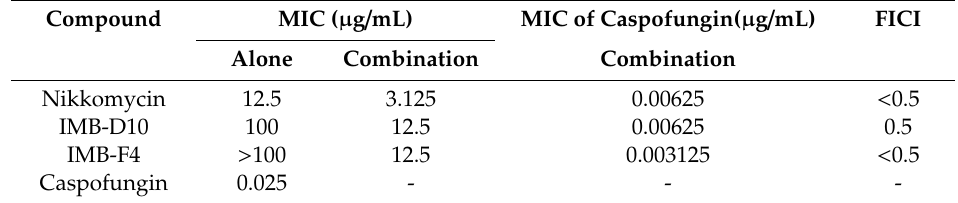
Table 3. The synergetic e ff ect of compounds IMB-D10 and IMB-F4 with caspofungin against Candida albicans. Compound MIC ( µ g /